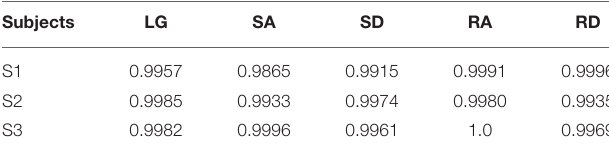
TABLE 4 | The AUC for each locomotion mode and each subject based on QDA.